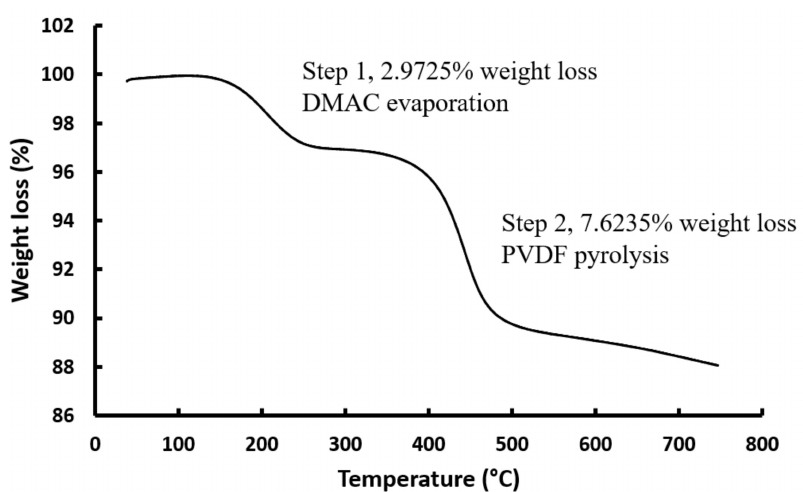
Figure 7. Thermogravimetric Analysis (TGA) of the 30 min wet mixture with N , N -dimethylacetamide (DMAC) as solvent and dried at 130 ◦ C for 12 h.